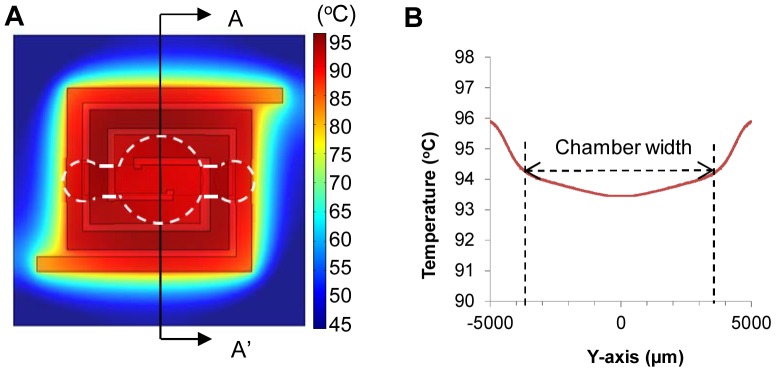
Simulated temperature profile of the microchip.(A) COMSOL Multiphysics® simulation showing uniform temperature distribution in the PCR chamber region when heated to 94°C (White dotted line shows the position of the reaction chamber). (B) Temperature profile across A-A’ shows the uniformity of the temperature in the chamber region of the PCR microchip within 1°C variation when the PCR microchip is heated to 94°C.